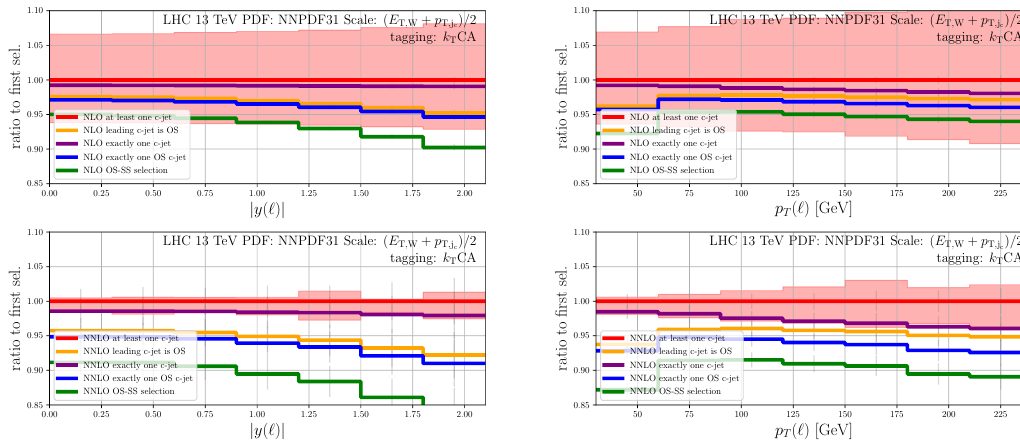
Figure 6 . Ratio of differential distributions in the rapidity (left) and the transverse momentum (right) of the charged lepton for the process pp → W + j the results at NLO QCD while the lower ones are for NNLO QCD. Various event selection for the charm jet are compared: at least one c-jet, the leading c-jet being of OS type, exactly one c-jet, exactly one c-jet of OS type, and the OS–SS